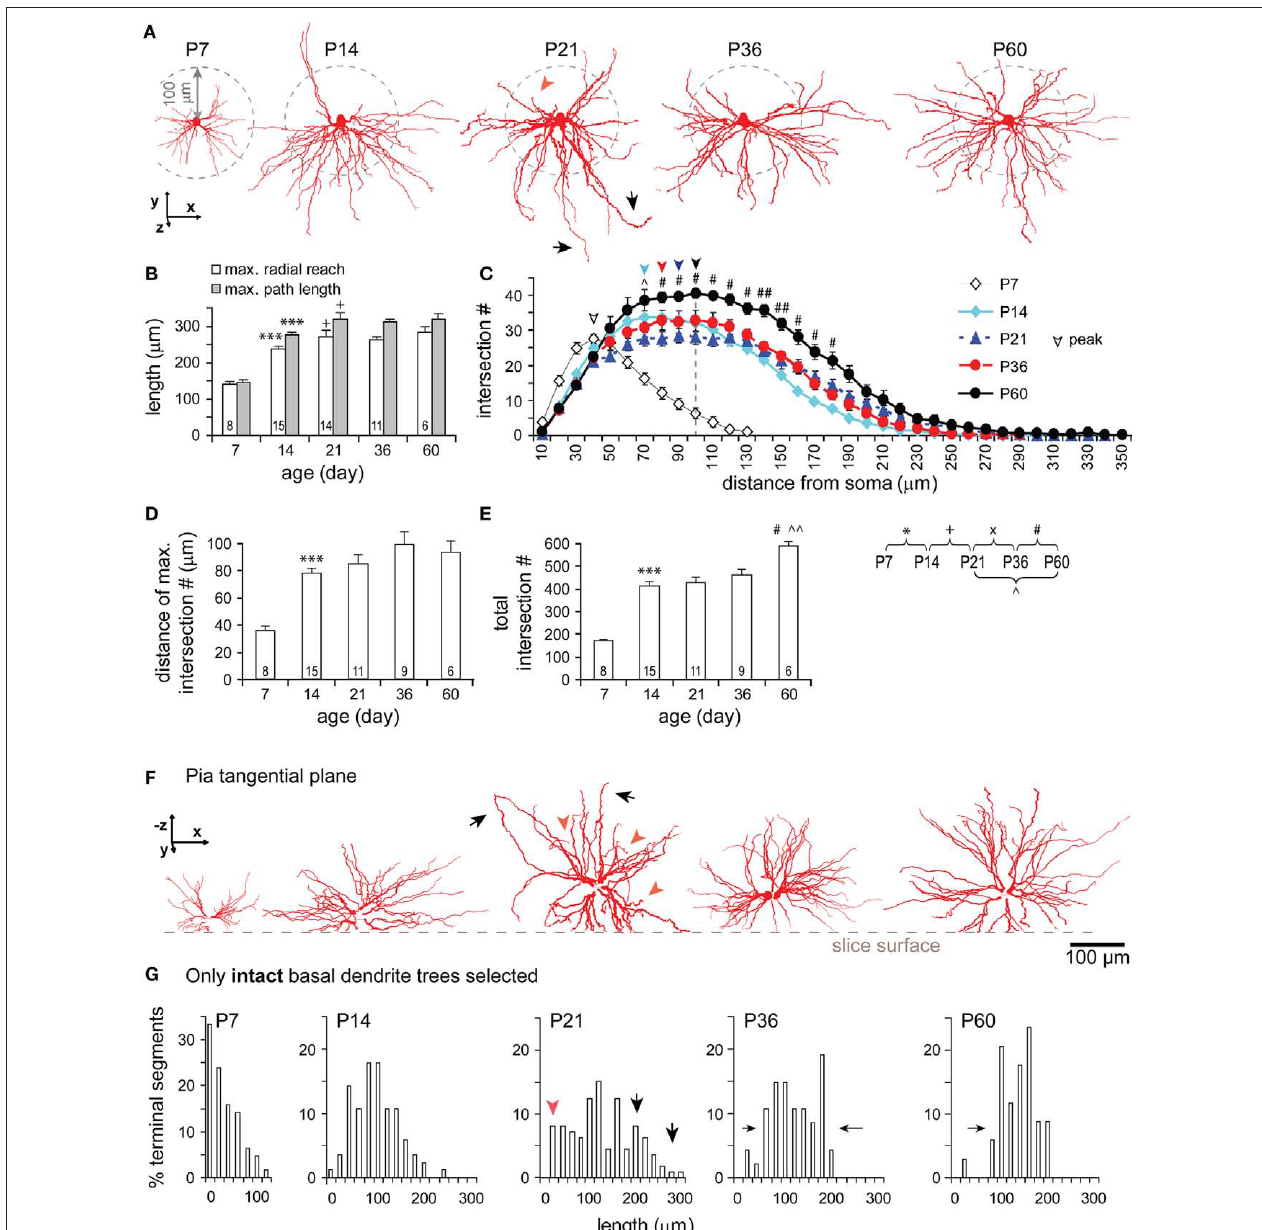
up from P36 to P60. (D) The distance of maximal intersection number (radius of sphere where the number of intersections is maximal) significantly increased from P7 to P14. (e) The total number of intersections (at all spheres) significantly increased at different periods (from P7 to P14, from P21 to P60, and from P36 to P60). (F) Representative reconstructions of basal dendrites viewed from the pial surface showing the cut of dendrites (same cells as above in sagittal view in A ). Note at P21, in both views, the concurrent presence of short (red arrowheads) and exceedingly long (black arrows) branches. (g) The percentage (%) of intact terminal segments as a function of their lengths over different ages (P7: n = 4 cells, 63 terminal segments; P14: 6, 84; P21: 11, 112; P36: 5, 47; P60: 3, 34). Note the distribution kept changing following development, featured with high percentages of short segments at P7, a symmetrical distribution centered around 100 μm at P14, broader distribution with more short (20–40 μm, red arrowhead) as well as long (200–320 μm, black arrows) lengths at P21, gradually narrowed distributions at P36 and P60. Scale bars, 100